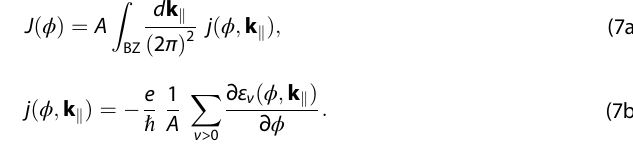
j J ð ϕ Þj (blue squares), ϕ j [Eq. (6), black curve]. All 1